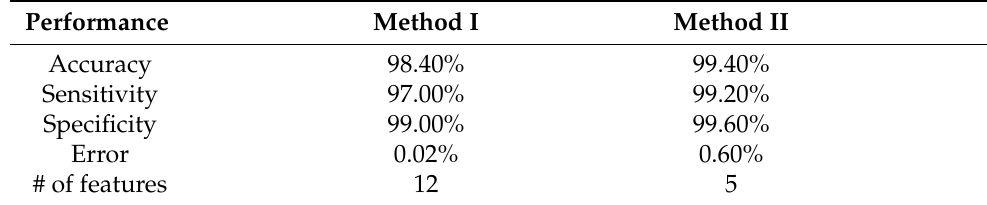
Table 15. Performance comparison of methods I and